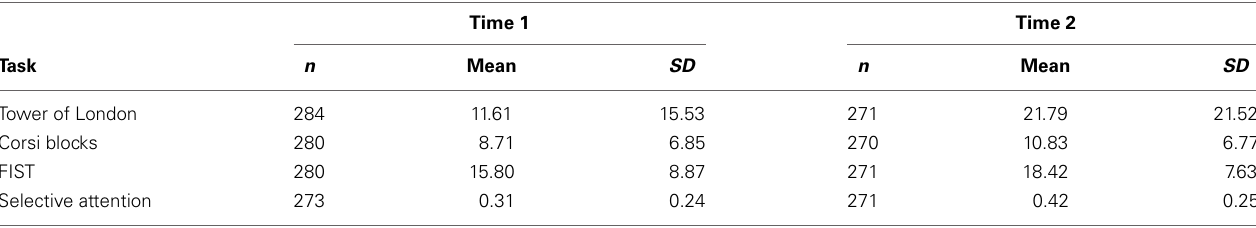
Table 11 | Performance by task and time of assessment in the CTP.